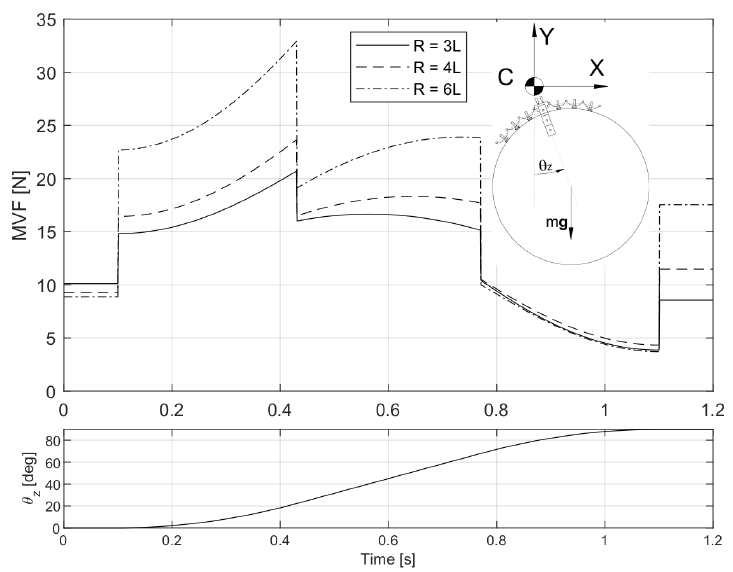
Figure 10. ( Upper plot ): Minimum vacuum force required during the manipulation of spheres with different dimension as a function of time. ( Bottom plot ): Angle θ z that defines the rotation of the